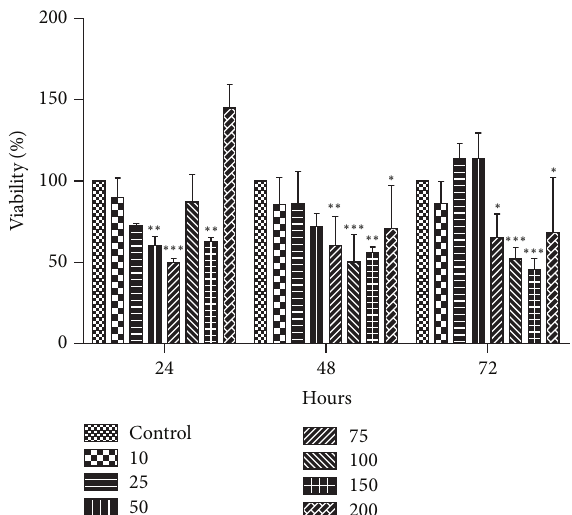
Figure 1: Effects of different concentrations of quercetin on cell viability. Cells were treated with different concentrations of quercetin (10– 200 𝜇 M) for 24, 48, and 72 hours and cell viability was measured by WST-1 assay. All data points represent mean ± SD, 𝑛 = 3 . Differences between means and significance of the treatments were analyzed using ANOVA and Bonferroni posttest. ∗ 𝑝 < 0.05 versus control, ∗∗ 𝑝 < 0.01 versus control, and ∗∗∗ 𝑝 < 0.001 versus